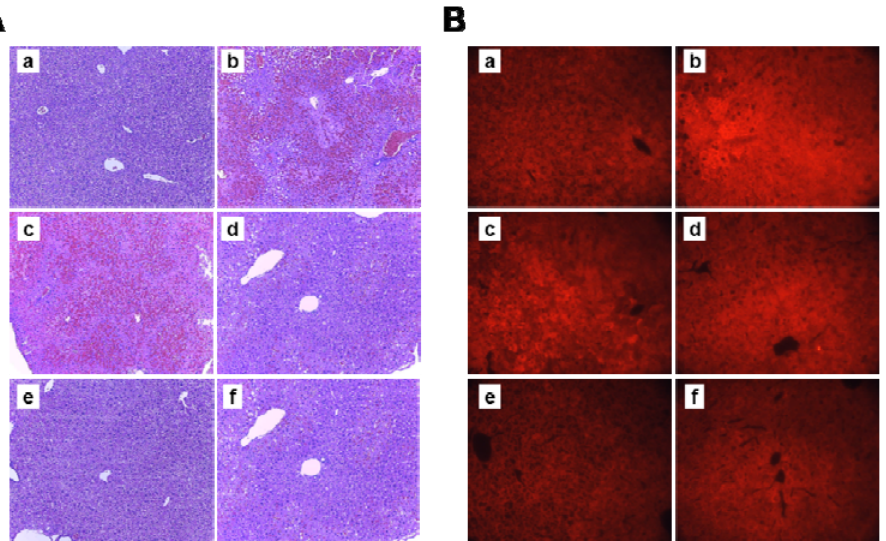
Figure 4. Ameliorative effects of OTC on APAP-induced centrilobular necrosis and nitrotyrosine production. Mice were orally treated with saline or OTC or NAC 2 h before injection of 300 mg/kg APAP. Twelve h after APAP injection, liver sections were stained with ( A ) H&E and ( B ) anti-nitrotyrosin antibody. Representative images of the livers from ( a ) untreated control mice, ( b ) 300 mg/kg APAP, ( c ) APAP + 25 mg/kg